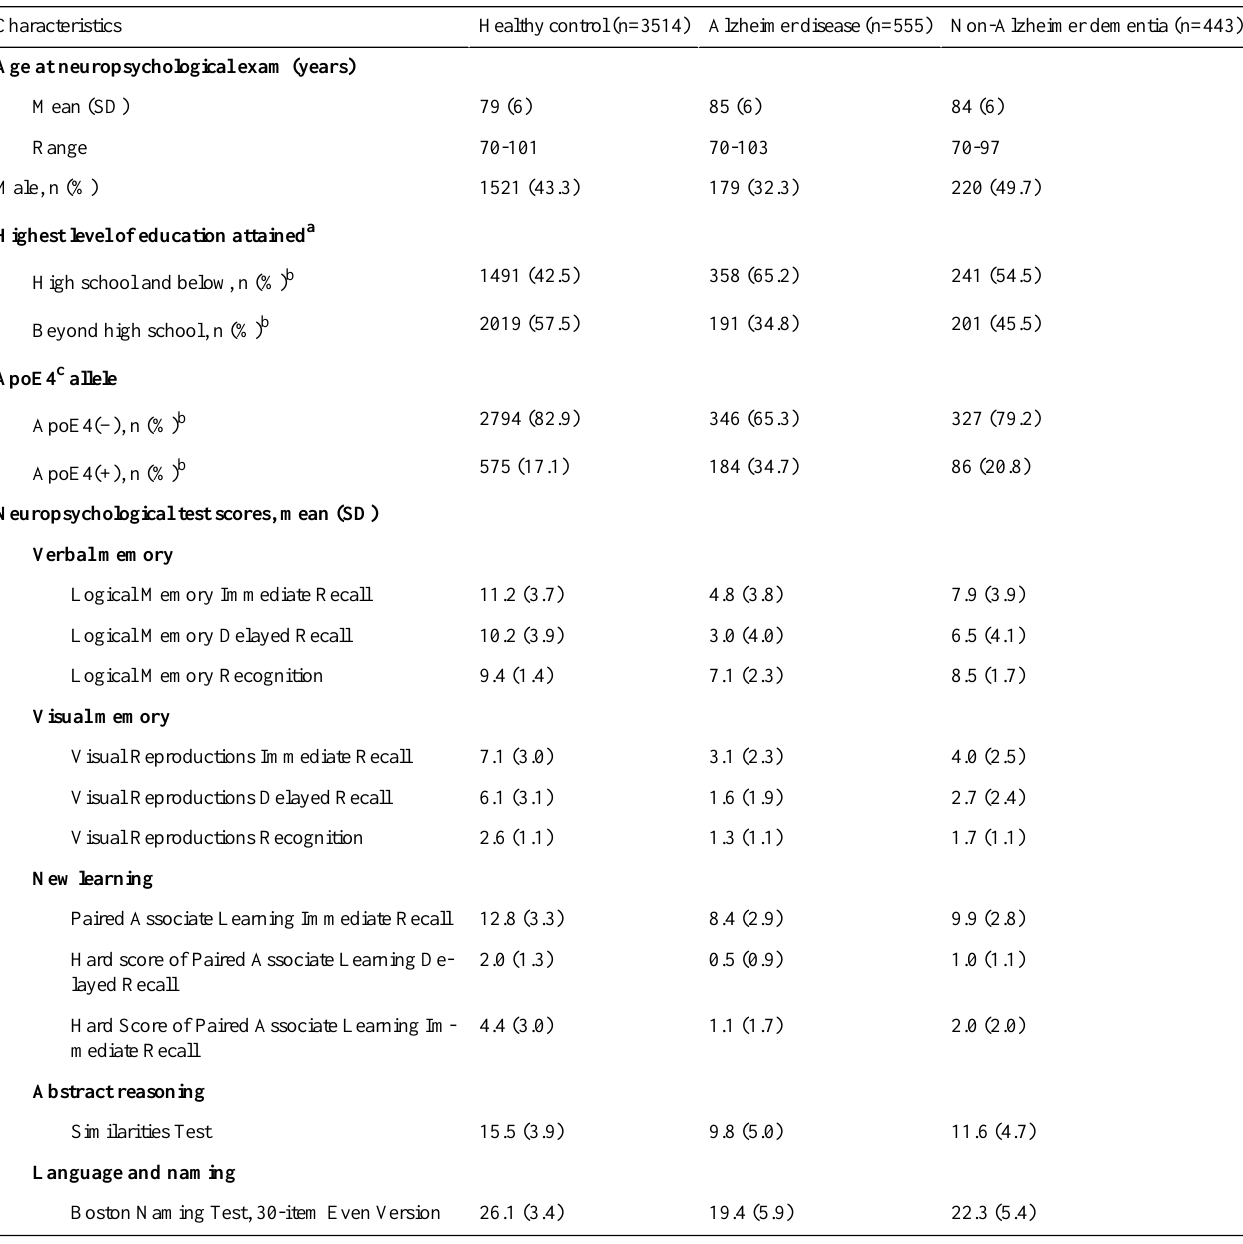
Table 1. Clinical characteristics of study samples. A total of 4512 sets of neuropsychological tests from 2091 participants were